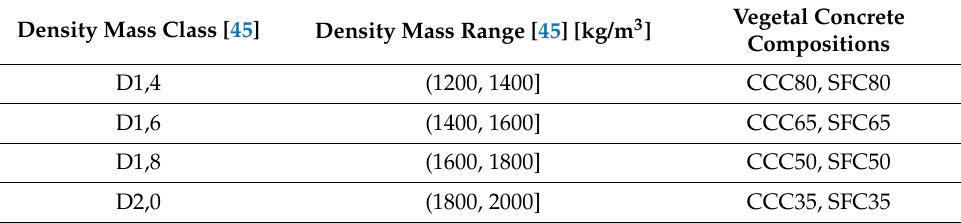
Table 2. Classification of lightweight concretes developed in this research by density